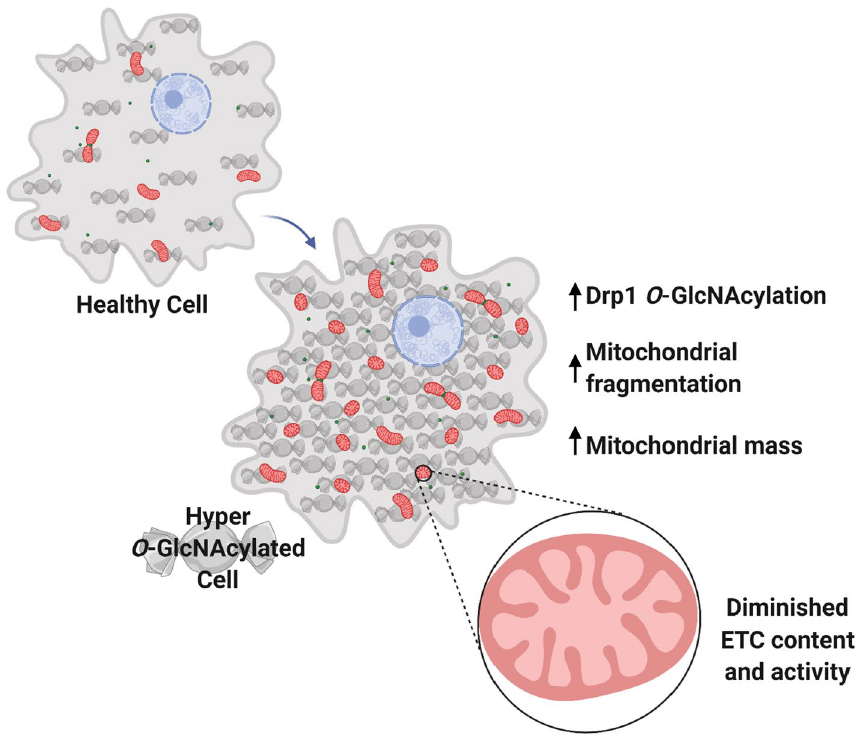
Figure 6. Model of the Effect of Hyper- O -GlcNAcylation on Mitochondrial Structure and Function. Elevated O -GlcNAcylation (represented by candies) within the cellular environment leads to mitochondrial fragmentation (executed by Drp1, green dots) and diminished ETC content and activity. A compensatory increase in mitochondrial mass compensates for these local defects, leading to relatively normal respiratory capacity when compared to a healthy cell with proper O -GlcNAc cycling. Model created with